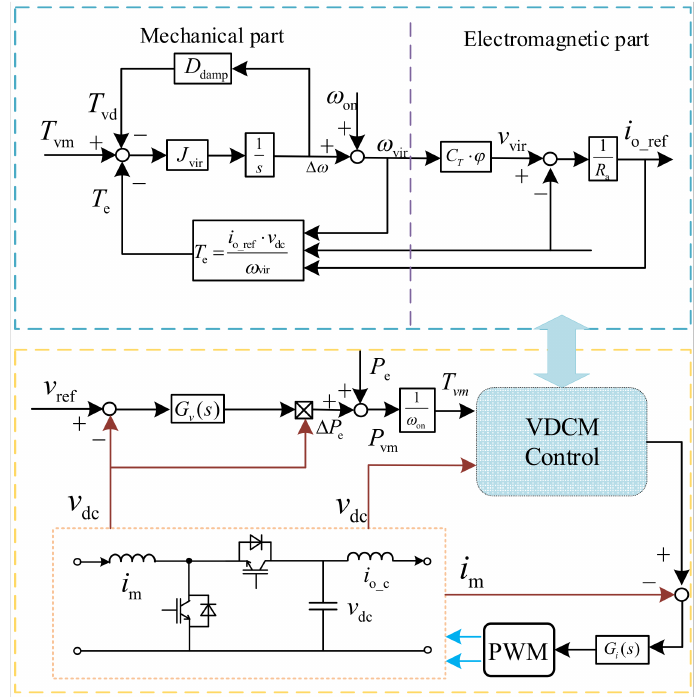
Figure 15. Control architecture for proposed VDCM control in Reference